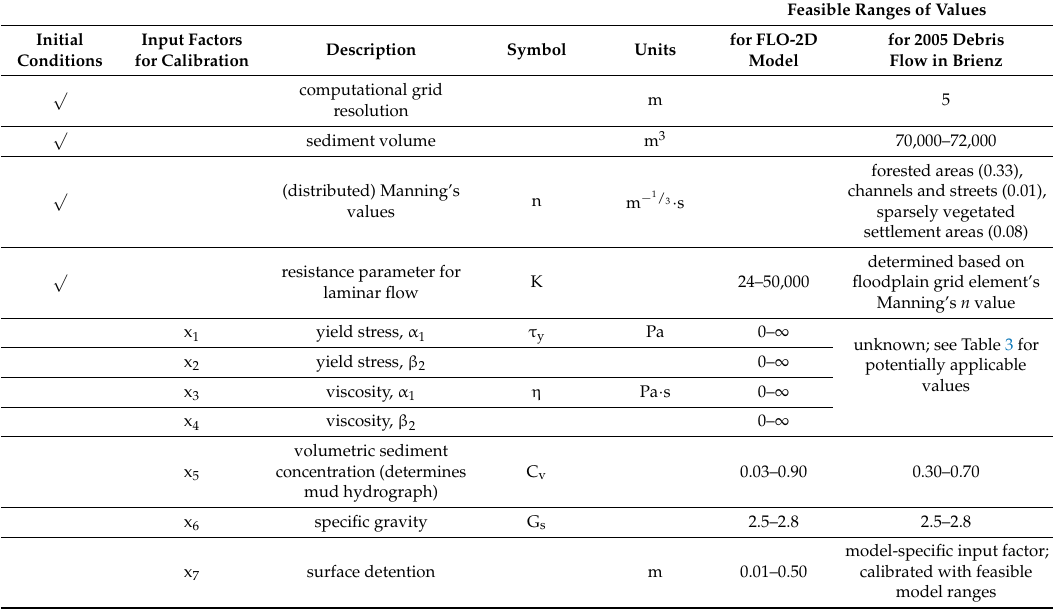
Table 2. Overview of required inputs in FLO-2D and feasible ranges of values specific to the 2005 debris flow event that occurred in